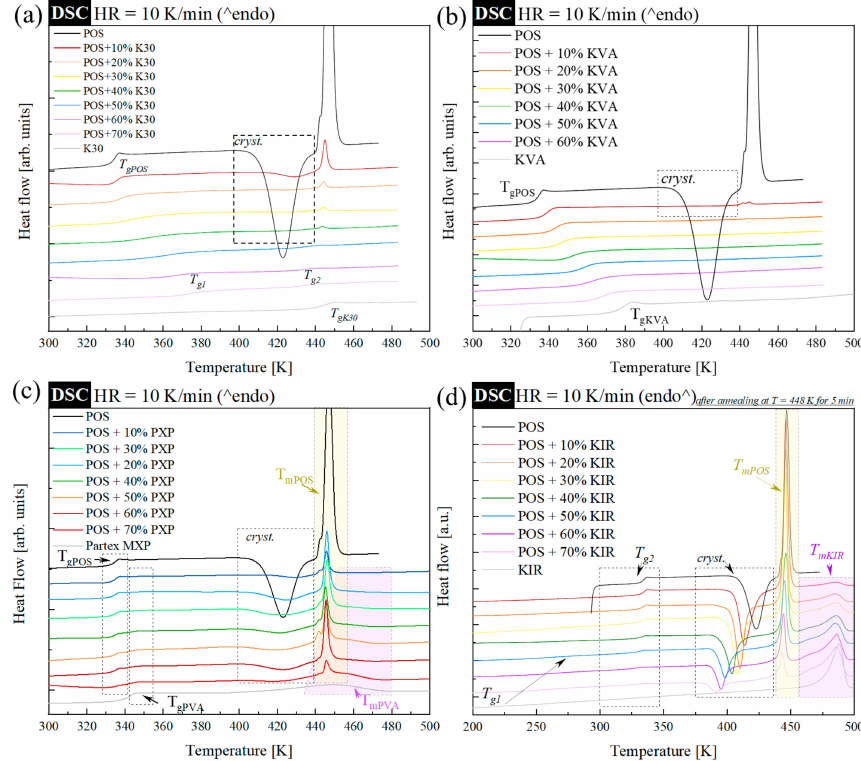
Figure 3. DSC thermograms of melt quenched binary systems containing amorphous POS, and from 10–70 wt.% of ( a ) Kollidon 30 (K30), ( b ) Kollidon VA64 (KVA), ( c ) Parteck MXP (PXP), and ( d ) Kollicoat IR (KIR). In each panel, the uppermost thermogram represents the DSC trace of amorphous POS, while the lowest thermogram originates from neat (dry)